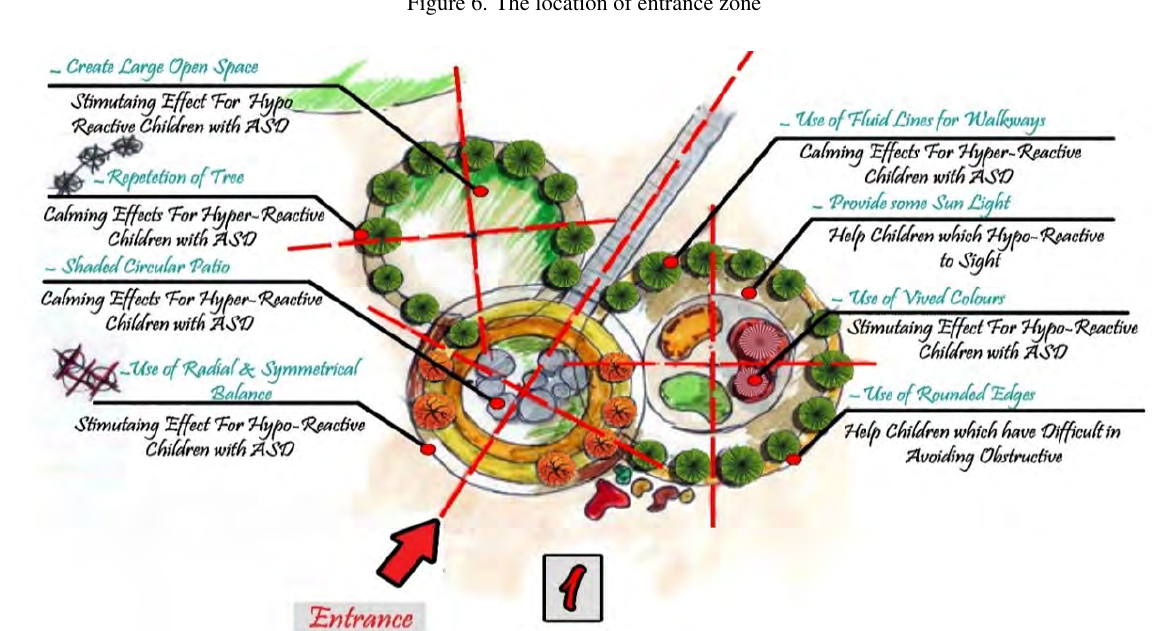
Figure 7. Shows the design consideration for the entrance zone